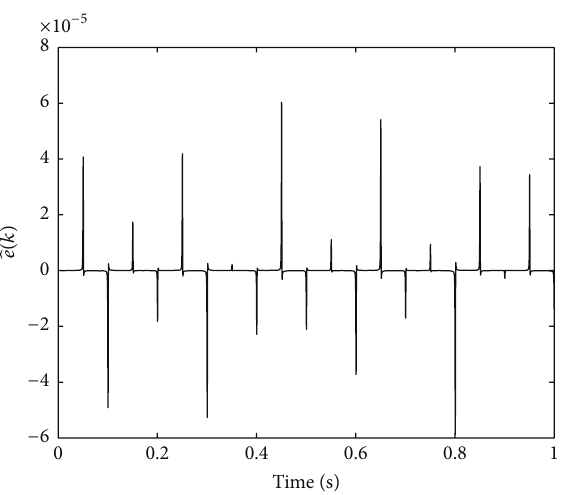
Figure 9: Output estimation error with (b).